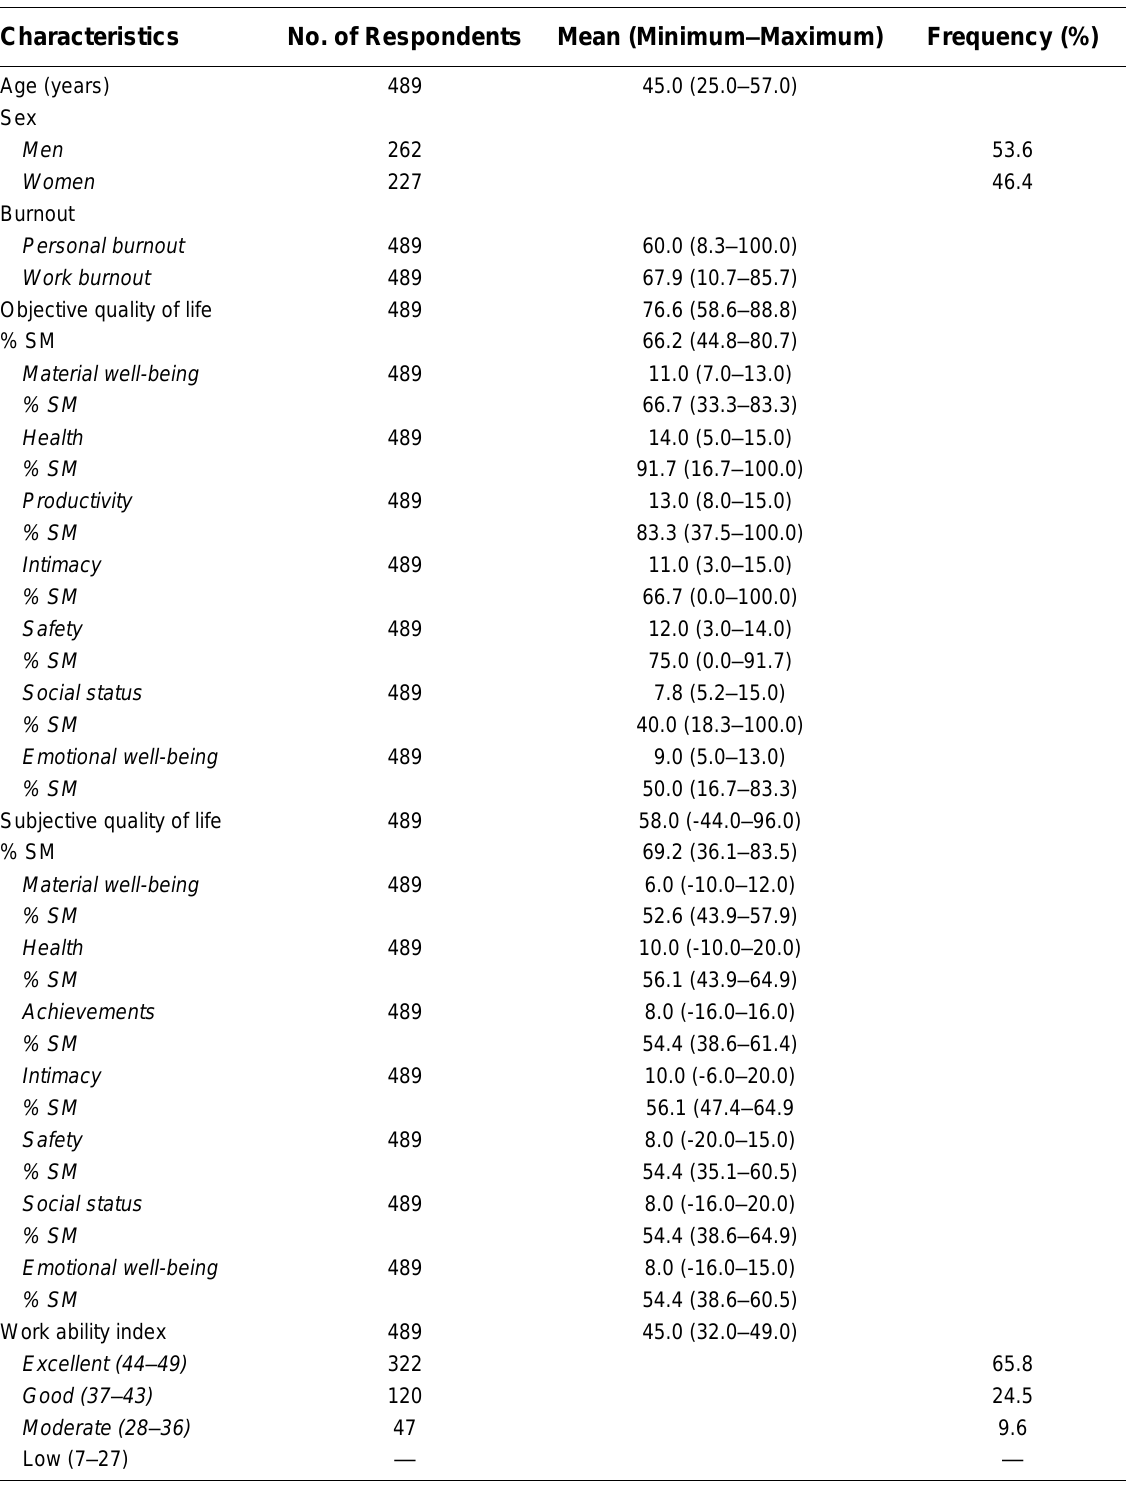
Characteristics of Respondents: Age, Sex, Burnout, Quality of Life and Work Ability Index Scores